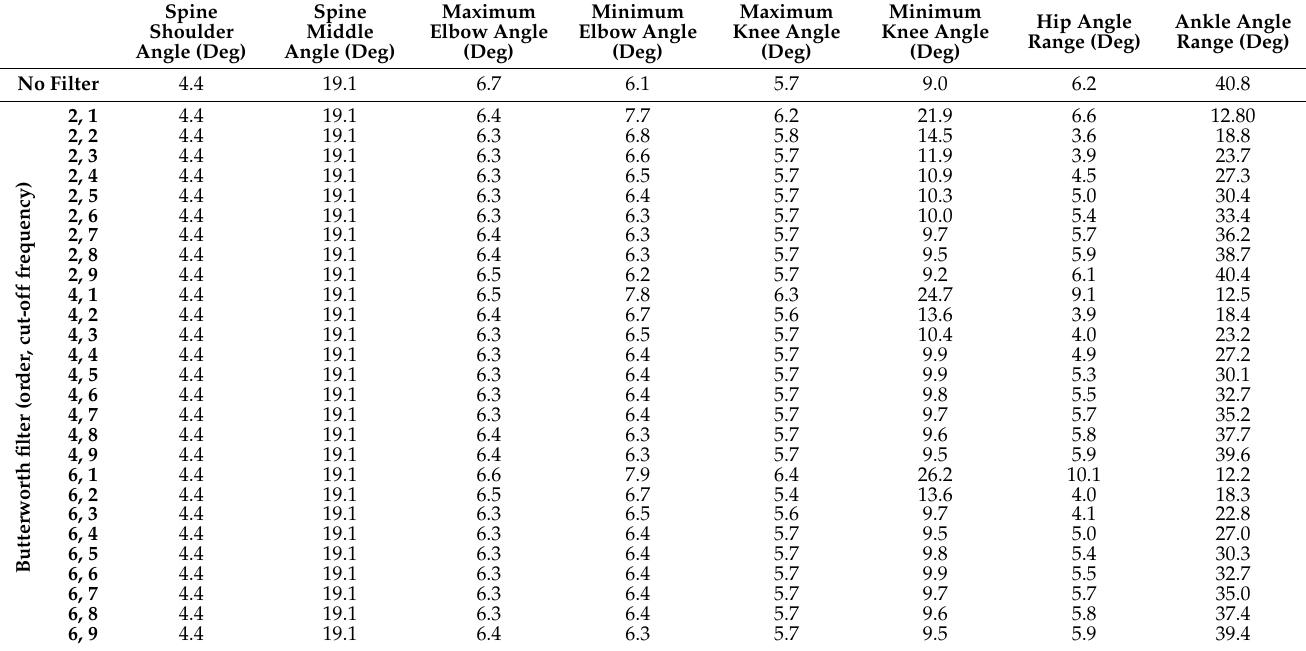
Table A2. Mean absolute error between Kinect and Qualisys for the kinematic gait parameters, without filtering and when varying the Butterworth filter’s order between 2 and 6 (even integer values), and cut off frequency between 1 and 9 Hz (integer values). The result corresponding to the chosen value for each gait parameter is underlined.